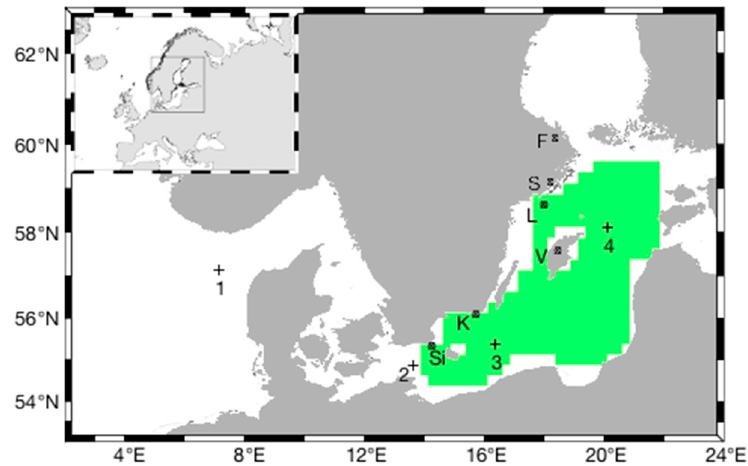
Figure 1. Map of the Baltic Sea. Green color denotes the area of the Baltic Sea Proper used to estimate the mean SLA. Positions of selected pixels (1–4) used in the discussion of Sea Level Anomalies are indicated by crosses, while coastal tide gauge stations are indicated by black dots (Si = Simrishamn. K = Kungsholmsfort. V = Visby. L = Landsort Norra. S = Stockholm. F = Forsmark). The insert in the upper left corner shows the location of the Baltic Sea in Europe.